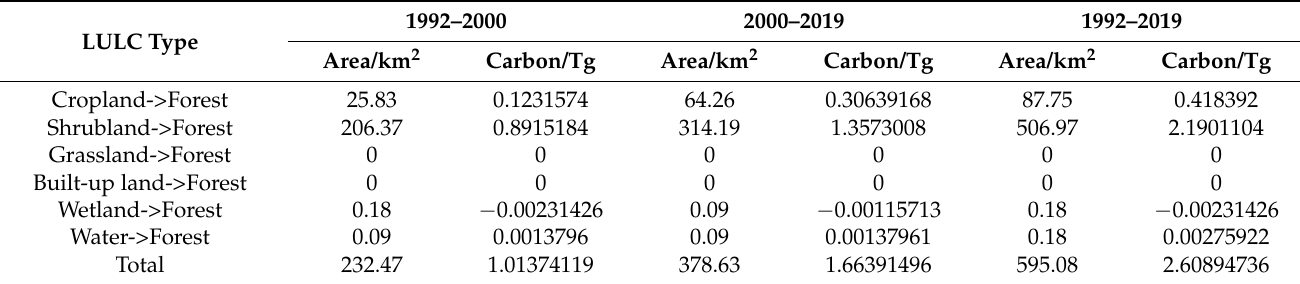
Table 5. Changes in carbon storage from the conversion of other land types to